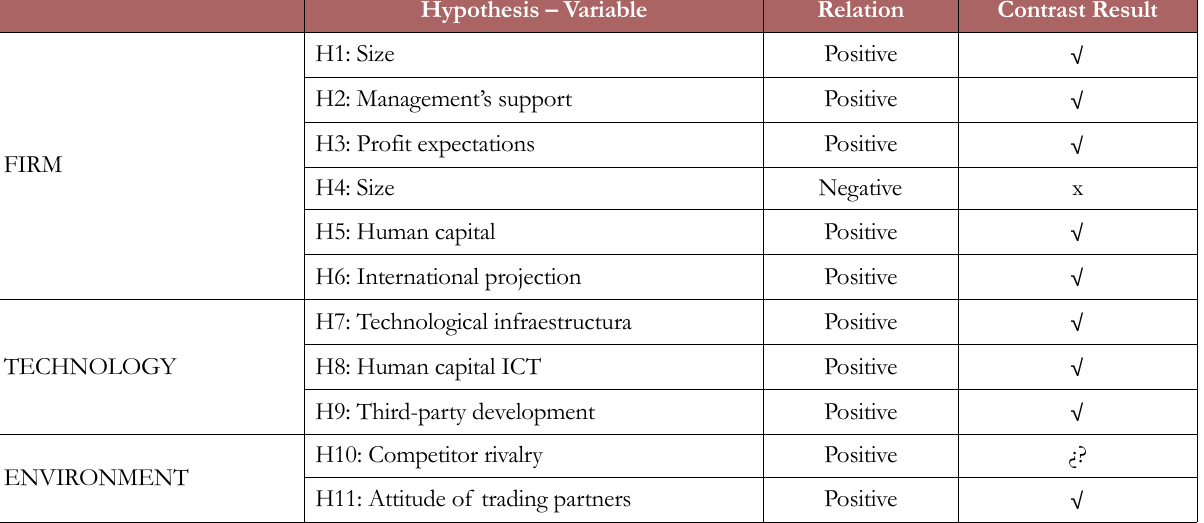
Table 10. Summary of results for the estimation of multinomial logistic regression